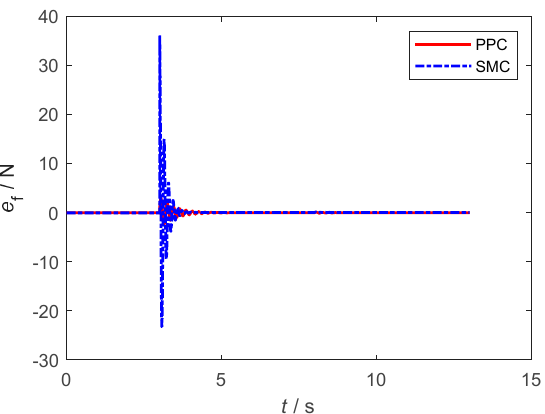
Figure 9. Force tracking error curve of space robot end on-orbit insertion operation.